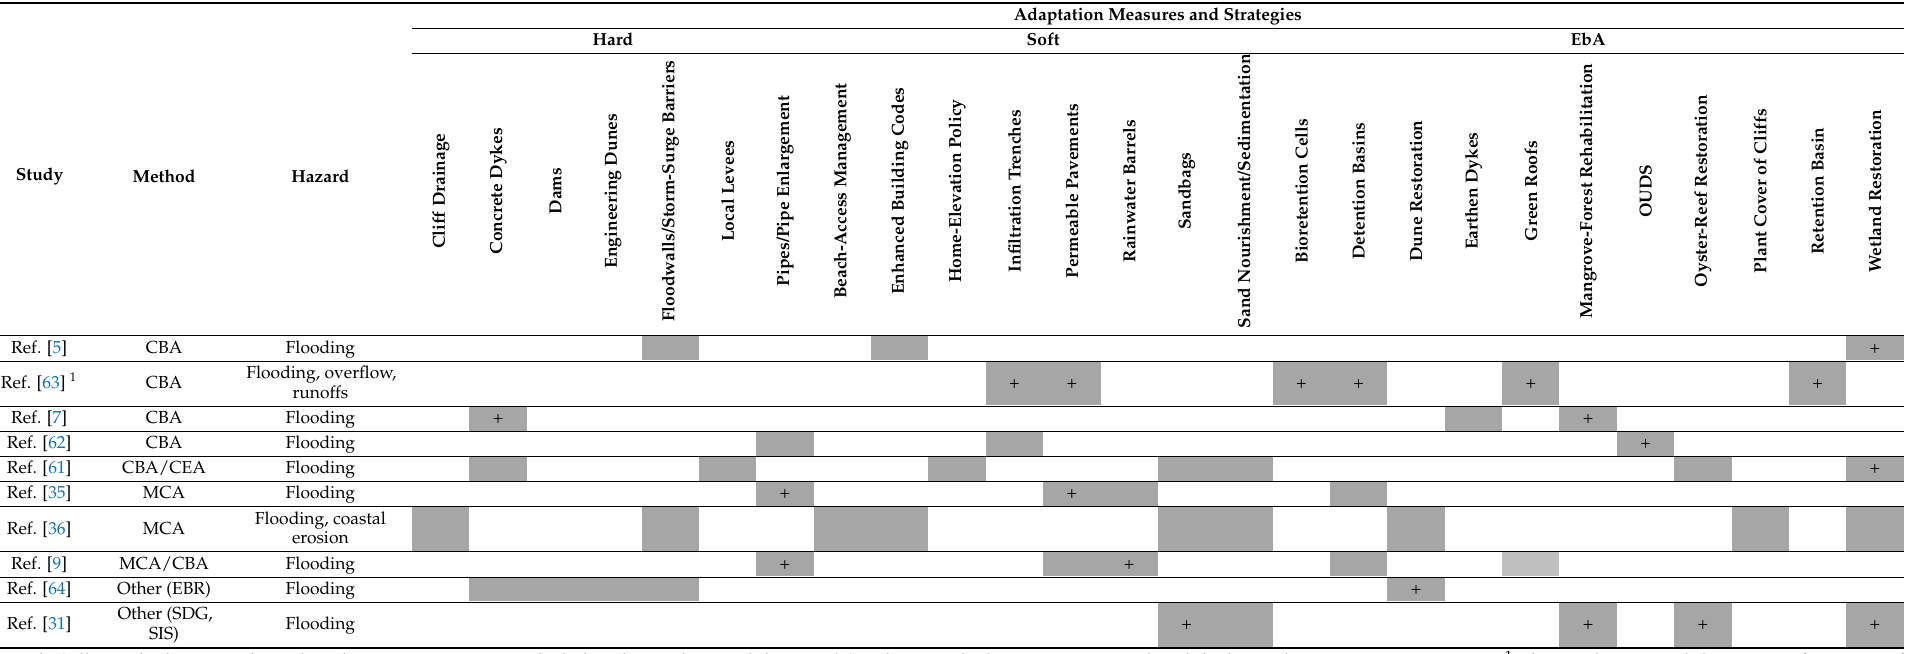
Table 7. Studies comparing EbA with hard and/or soft adaptation